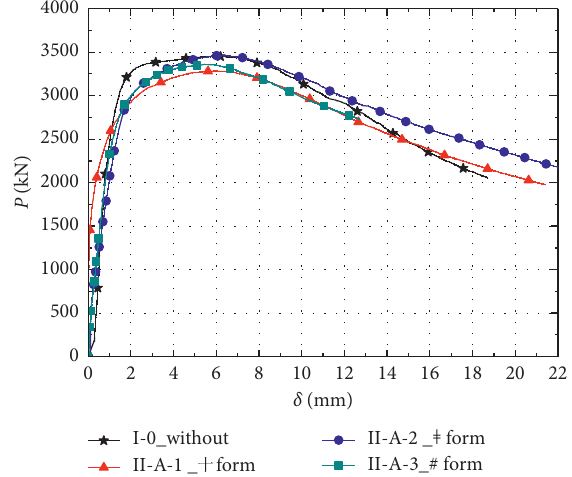
Figure 9: Effects of stiffener on LYP steel tubular